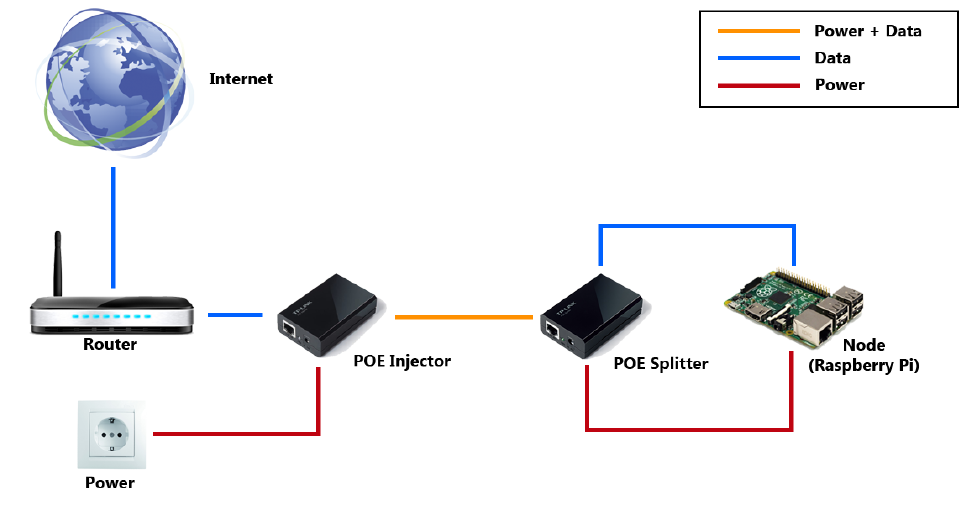
Figure 1. Operation scheme for the power and Internet connectivity via Power over Ethernet (POE), IEEE